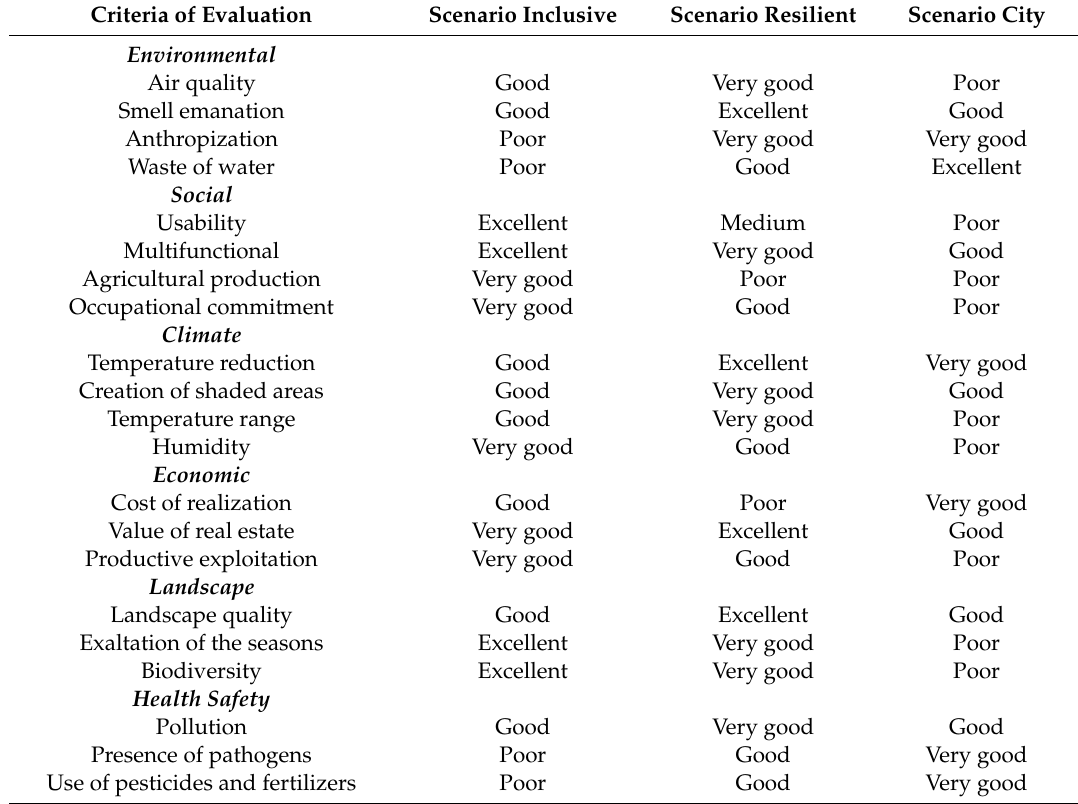
Table 3. Evaluation of the results of the impact matrix of the various